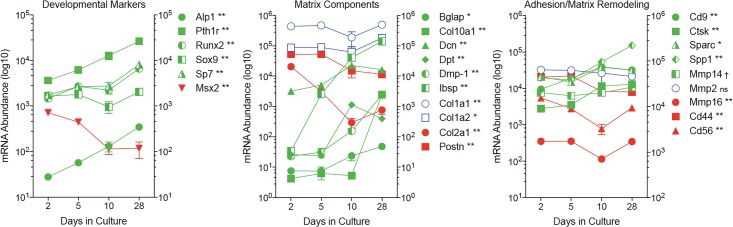
Temporal changes in the abundance of mRNA encoding bone marker proteins.Total RNA was isolated from triplicate cultures of MC3T3-E1 cells at days 2, 5, 10 and 28 in culture, and mRNA abundance quantified by NanoString nCounter using a bone focused probe set (S1 Table). Developmental markers shown are: alkaline phosphatase (Alp1); parathyroid hormone receptor (Pthr1); the transcription factors Runx2, Sox9 and Sp7; and the transcriptional repressor Msx2. Matrix components shown are: bone gamma-carboxyglutamate protein (Bglap); collagen types 1A1 (Col1a1), 1A2 (Col1a2), 2A1 (Col2a1) and 10A1 (Col10a1); decorin (Dcn); dermatopontin (Dpt); dentin matrix protein-1 (Dmp-1); integrin-binding sialoprotein (Ibsp); and periostin (Postn). Proteins associated with cell adhesion and matrix remodeling are: tetraspanin (Cd9); cathepsin K (Ctsk); osteonectin (Sparc); osteopontin (Spp1); matrix metalloproteinases 2 (Mmp2), 14 (Mmp14), and 16 (Mmp16); hyaluronic acid receptor (Cd44); and neural cell adhesion molecule 1 (Cd56). Data shown represent the Mean ± SD of three biological replicates at each time point. Error bars not shown are smaller than the symbol. † P < 0.05; * P < 0.01; ** P < 0.001 different in abundance between at least two time points by two-way ANOVA with Tukey’s multiple comparisons test; ns, not significant.